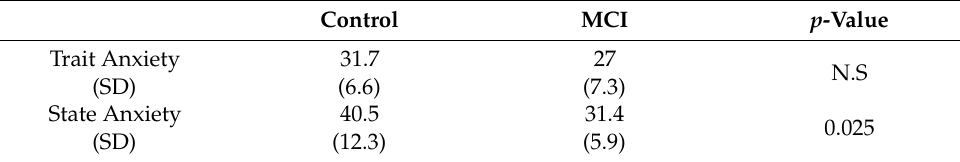
Table 2. Group differences in memory and affect